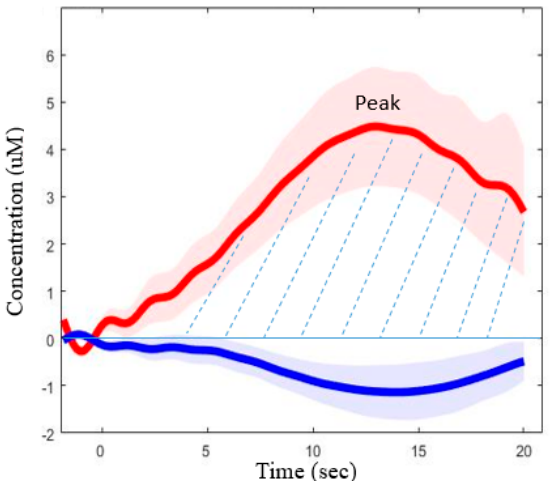
Figure 4. A typical fNIRS curve. The peak amplitude and the area under the curve (dotted lines) are extracted for further statistical analysis.